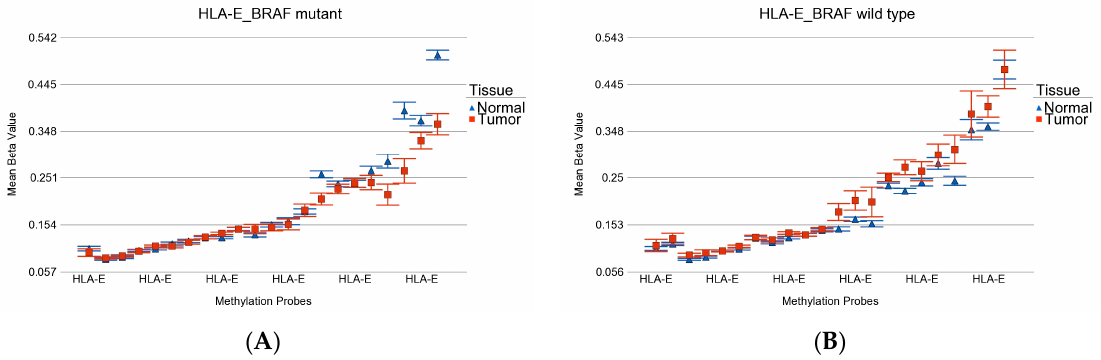
Figure 7. Differential methylation status of HLA-E . Differential methylation in BRAF mutant patients is shown in ( A ), and the differential methylation of BRAF wild-type patients is shown in ( B ). Note that multiple probes were hypomethylated in BRAF mutant tumor and hypermethylated in BRAF wild-type tumor.